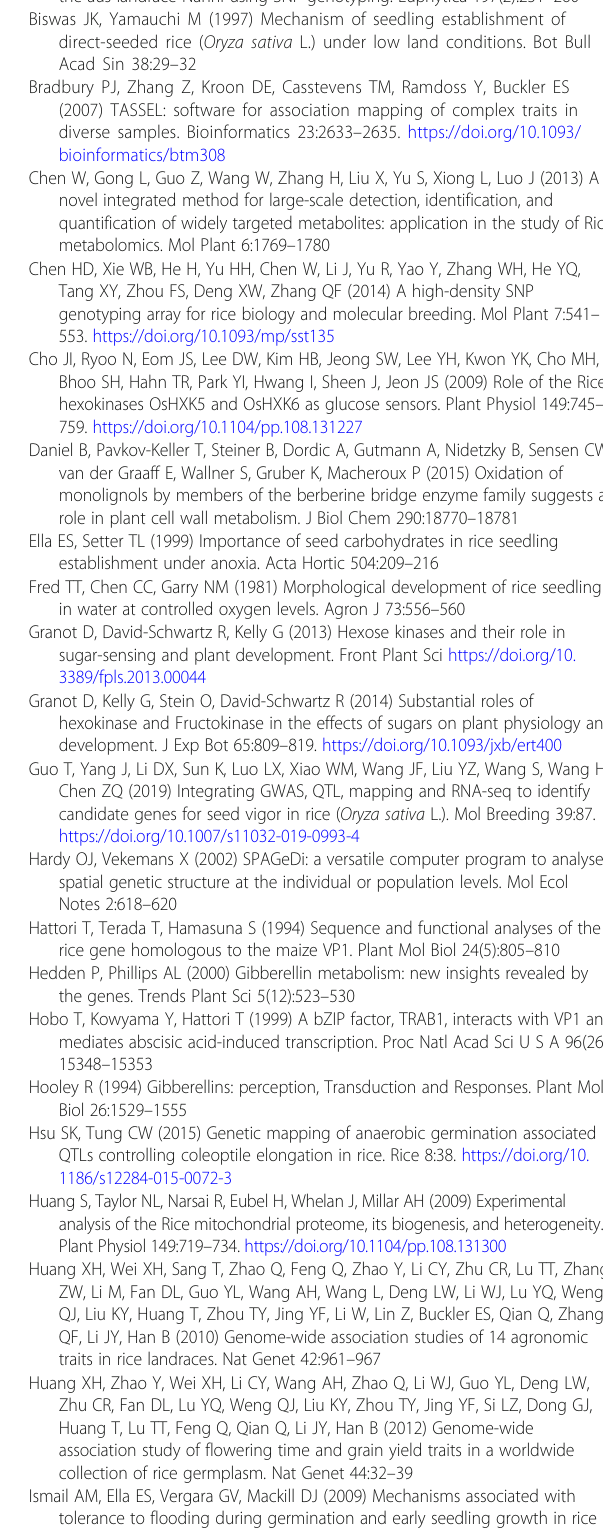
panel b is the detection in negative ion